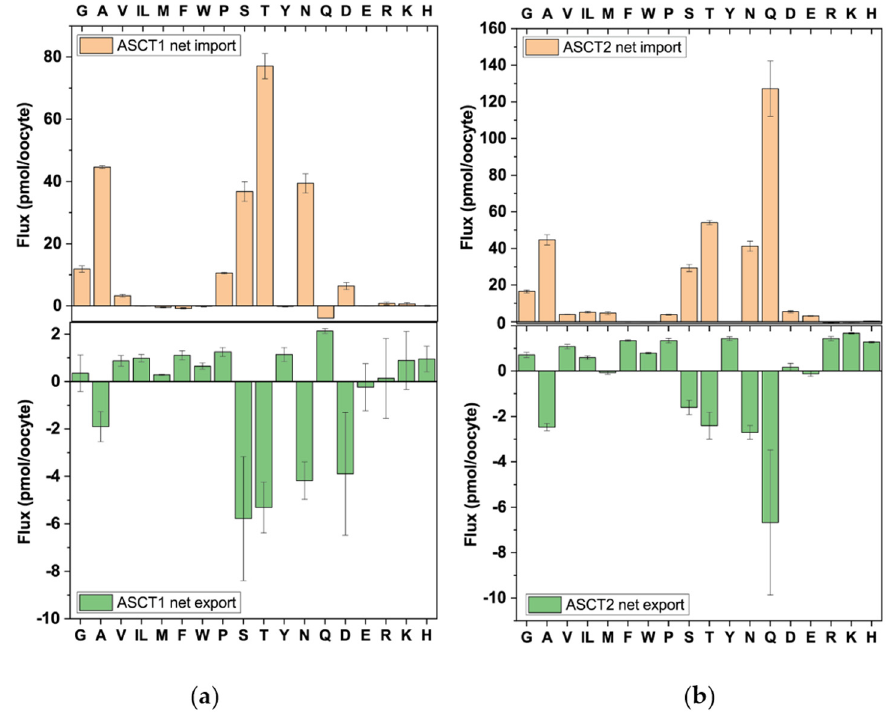
Figure 7. Analysis of antiport via ASCT1 and ASCT2. Oocytes expressing ASCT1 ( a ) or ASCT2 ( b ) were incubated with labelled and unlabelled amino acids as described in Figure 1a. Net import (positive numbers) and net export (negative numbers) are shown. Isoleucine and leucine cannot be separated by LC–MS and are shown as IL.